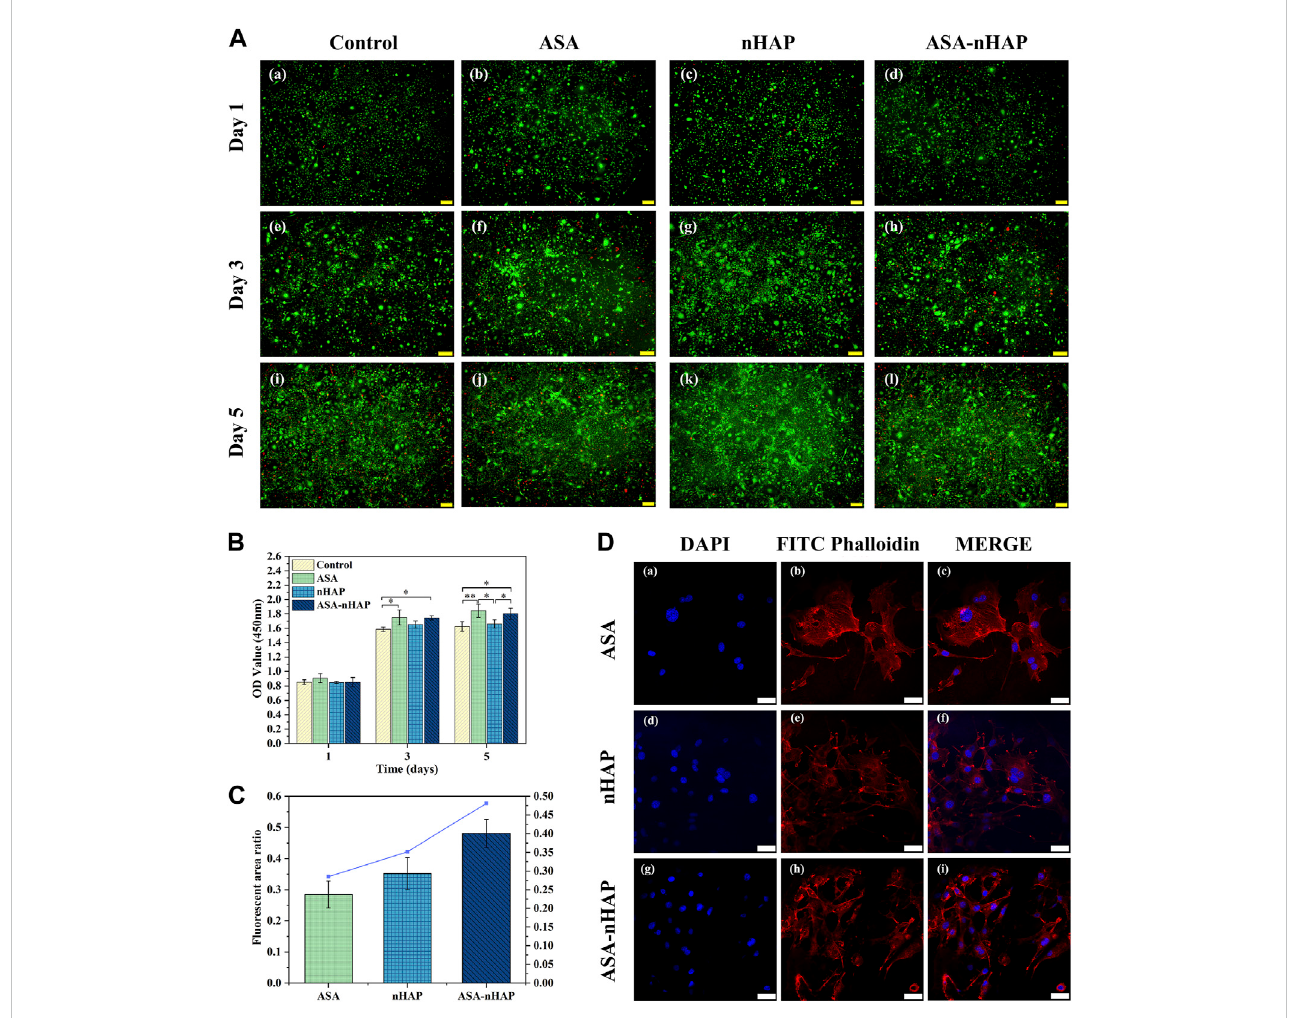
FIGURE 4 GrowthabilityofMC3T3-E1cellscultured invitro . (A) Live/deadstainingimagesofMC3T3-E1cellsculturedwiththehydrogelextractionsfor1,3,and5 d. (B) The OD value of the control group, ASA group, nHAP group, and ASA-nHAP group from the CCK-8 assay (* p < 0.05, ** p < 0.01). (C, D) Semi-quantitative analysis and laser confocal images of MC3T3-E1 cells on the ASA group, nHAP group, and ASA-nHAP group. Blue represents the nucleus stained by DAPI and red represents the cytoskeleton stained by FITC phalloidin at a scale bar of 40 μ